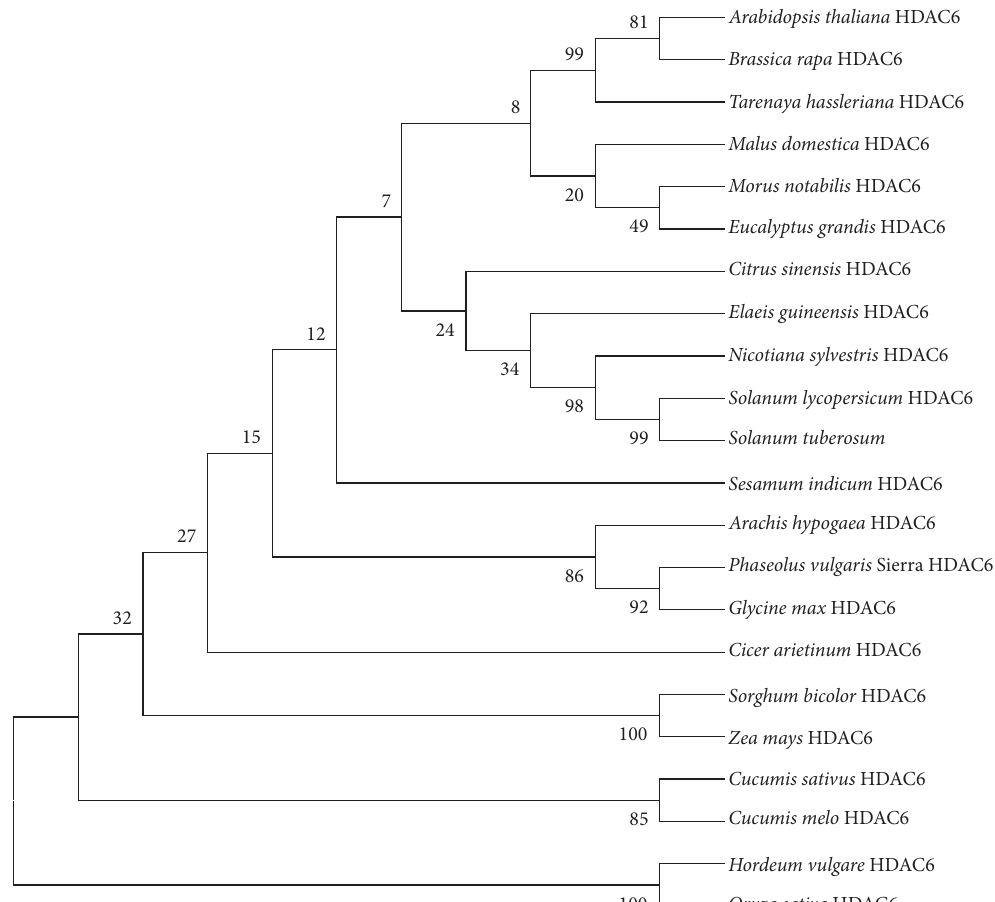
Figure 2: Phylogenetic analysis of HDA6 in monocots and dicots. The neighbor-joining tree was constructed with mRNA sequences of plant HDA6 using MEGA6. The tree indicates the evolutionary relationship between common bean HDA6 and other dicot and monocot